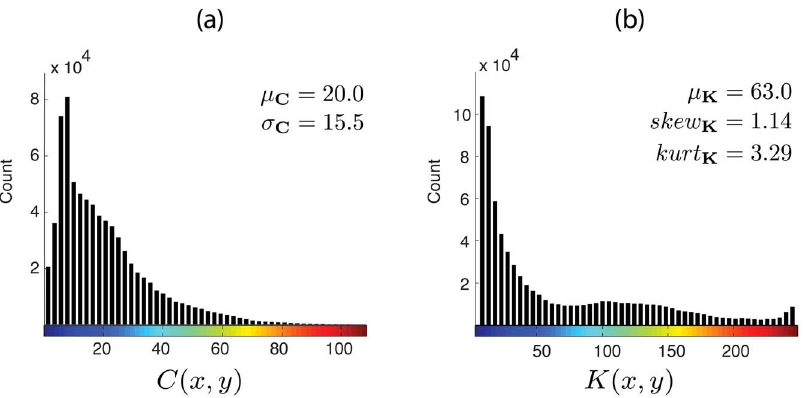
Figure 8. Statistics of contrast and kurtosis maps. (a) Histogram of the contrast map in Figure 7. (b) Histogram of the kurtosis map in Figure 7. The statistics of these p.d.f.s are presented at the top-right corner of the histograms. Colormaps for C ( x , y ) and K ( x , y ) values are preserved for easy understanding. plot 9(a), the mean contrast m C is given in function of r -values. The correlation coefficient between m C and the subjective rank is R = 0.56.